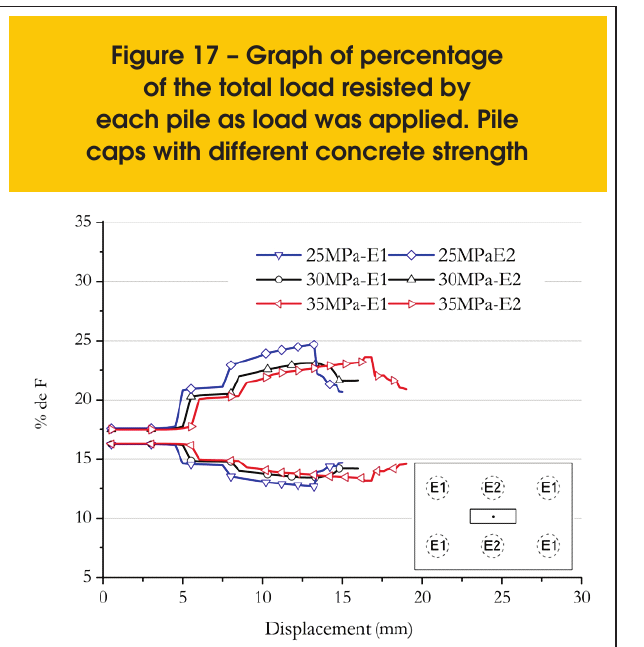
Figure 17 – Graph of percentage of the total load resisted by each pile as load was applied. Pile caps with different concrete strength